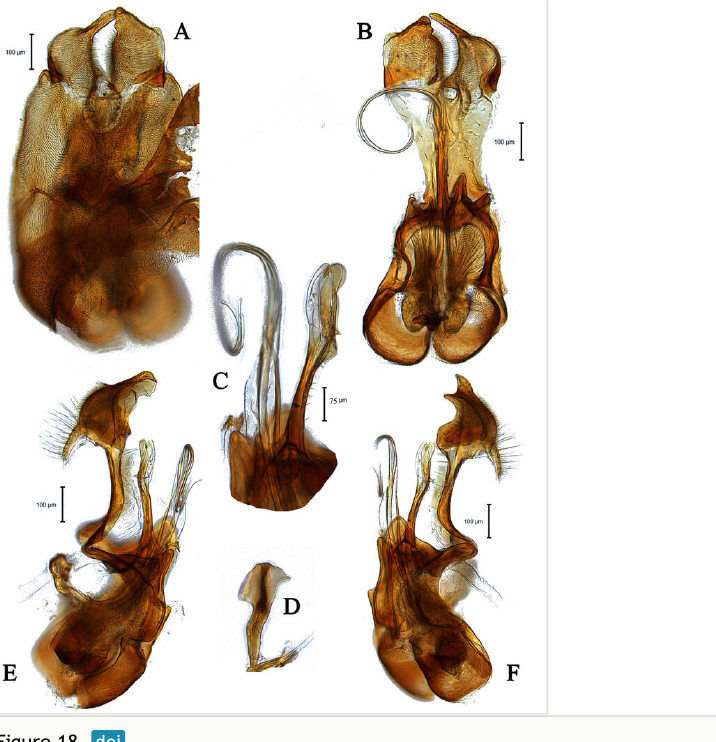
Figure 18. Male genitalia of Eudorylas pannonicus (JSS52207) (A) in dorsal view; (B) in ventral view; (C) phallus & phallic guide in ventrolateral view; (D) ejaculatory apodeme; (E,F) in lateral